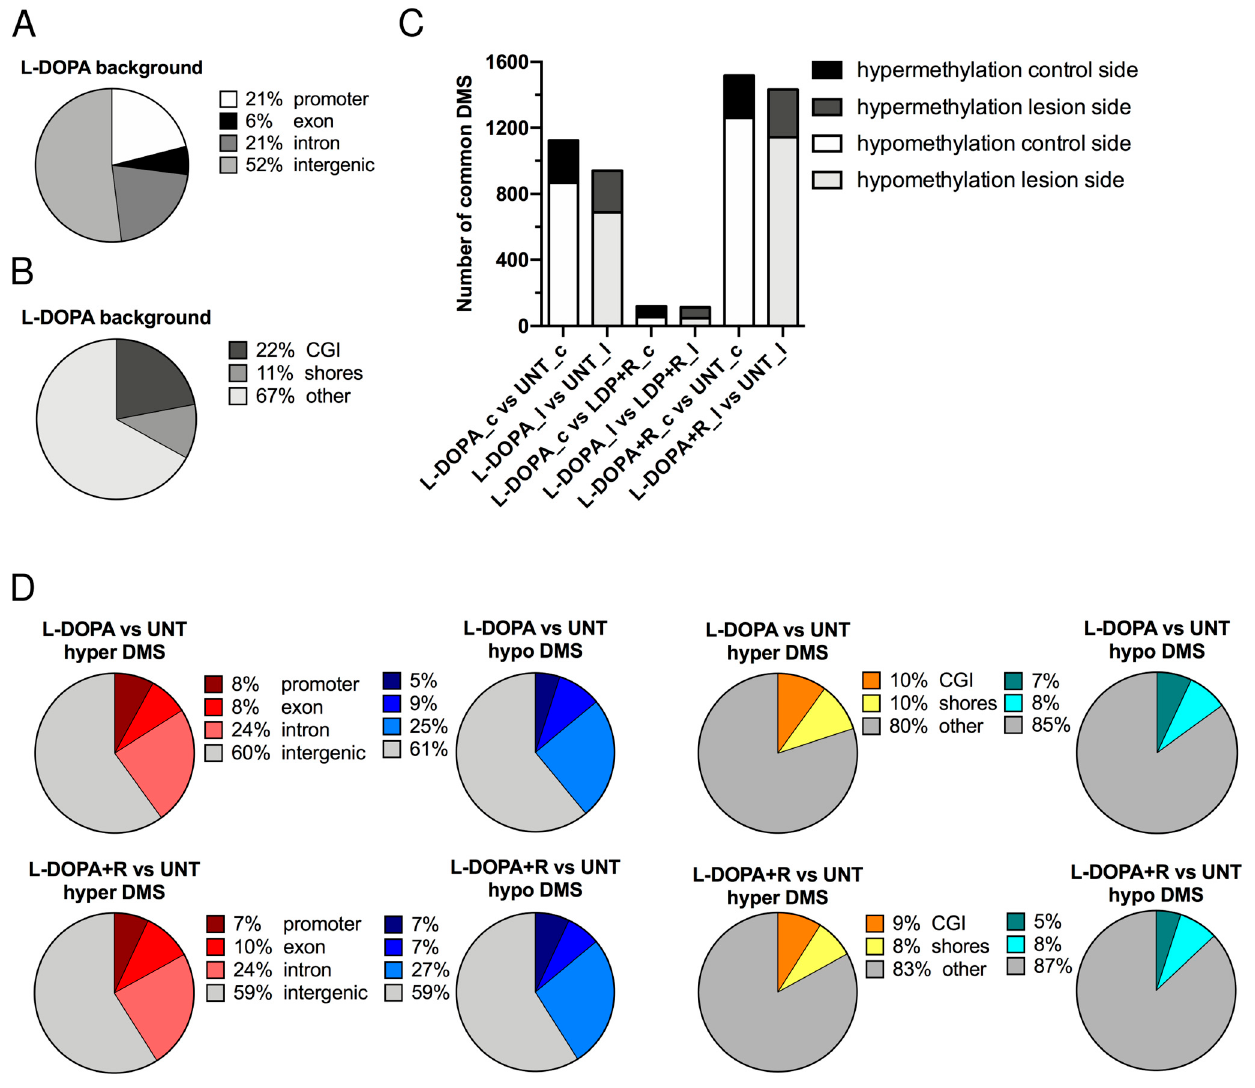
Figure 2. Distribution of CpGs detected by RRBS in the rat genome. ( A ) Distribution of CpGs in the genome (promoter, exon, intron, intergenic) ( B ) Distribution of CpGs in areas of different CG density (CpG island, CpG shores, other). ( C ) Number of differentially methylated sites (DMSs) in the experimental groups (L-DOPA vs. UNT control side, L-DOPA vs. UNT lesioned side, L-DOPA vs. L-DOPA + R control side, L-DOPA vs. L-DOPA + R lesioned side, L-DOPA + R vs. UNT control side, and L-DOPA + R vs. UNT lesioned side) classified as hyper- or hypomethylated. ( D ) Genomic distribution of CpG methylation changes. Distribution of hypermethylated and hypomethylated CpGs in L-DOPA treated vs. UNT rats. Distribution of hypermethylated and hypomethylated CpGs in L-DOPA + Riluzole treated vs. UNT rats.